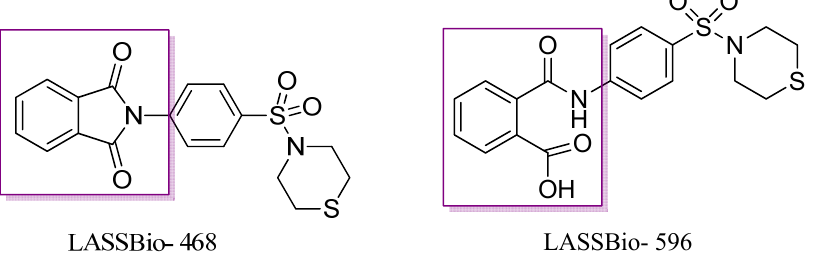
Figure 5. Prototype anti-asthmatic LASSBio hybride-468 and its active metabolite